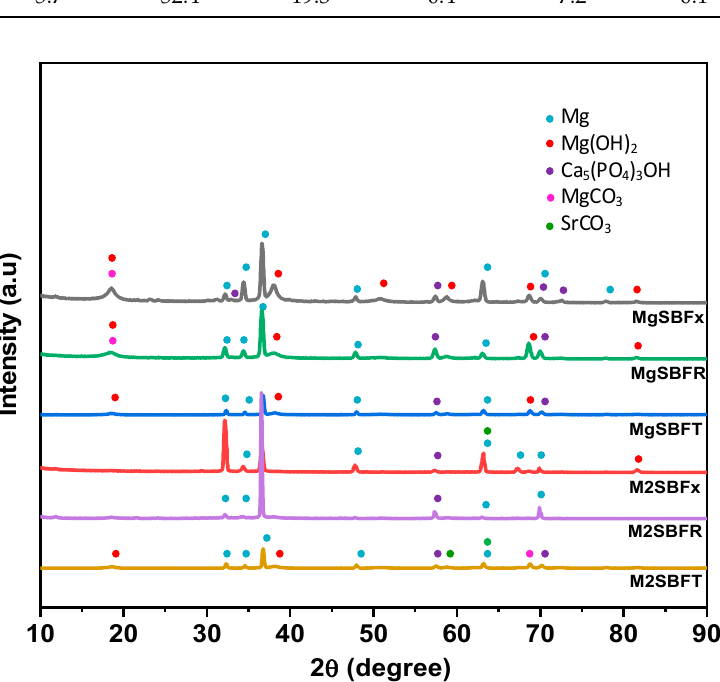
Figure 5. XRD peaks of CP Mg and Mg-1.0Ca-0.5Sr alloy after 14-day immersion in r-SBF corrosion media under different pH control conditions.